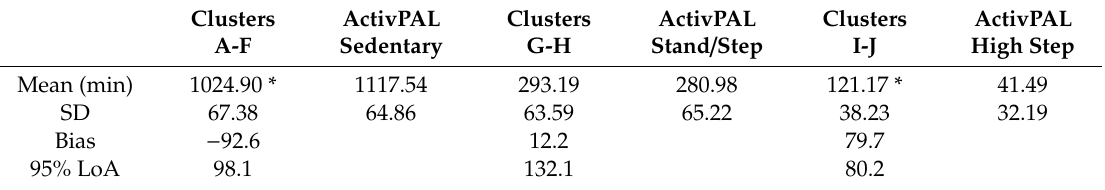
Table 6. Comparison of total daily minutes spent in activity type categories with the activPAL